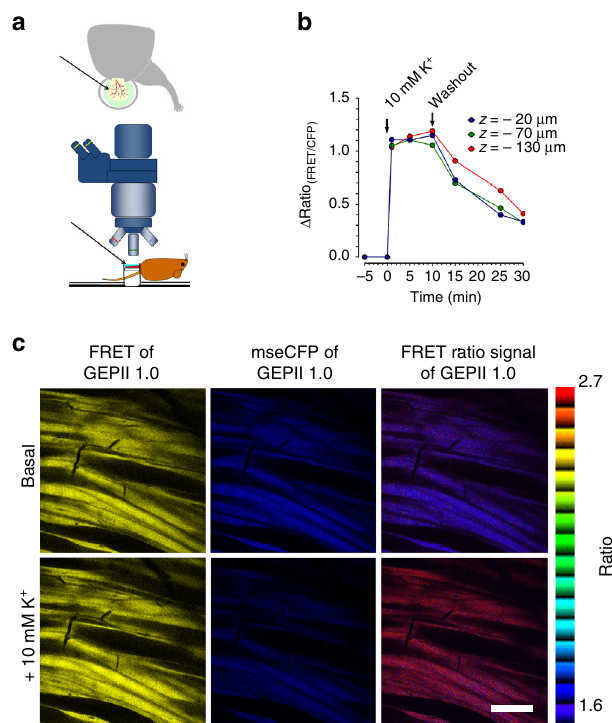
Fig. 4 Testing the functionality of recombinant GEPII 1.0 in vivo. a Schemes showing the area of interest (musculus cremaster, arrow, upper panel) and the mouse prepared for imaging using the 2-photon imaging device (lower panel). b Representative in vivo FRET ratio signals of GEPII 1.0 loaded into the cremaster tissue of a living mouse. Signals were imaged using a 2-photon fl uorescence imaging system at different z -positions. As indicated 10 mM KCl was applied to the tissue during intravital microscopy and subsequently washed out using a perfusion system. c Representative images showing the FRET signal (yellow, left images), mseCFP signal (blue, middle images) and FRET ratio signal (pseudocolored, right images) of GEPII 1.0 loaded into the musculus cremaster prior to (upper images) and upon the addition of 10 mM KCl (lower images) as indicated in b . White scale bar in the lower right image represents 100 µ